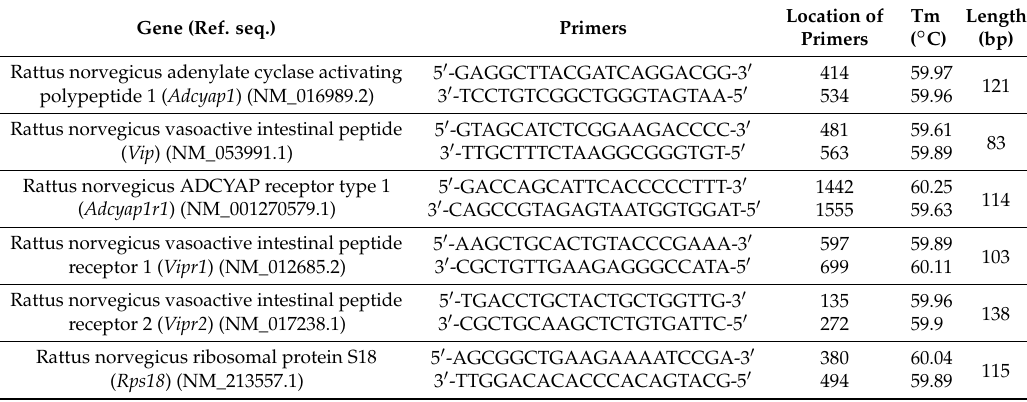
Table 1. Primer sets used to determine mRNAs changes within the VIP/PACAP system in the RT4 Schwann cell